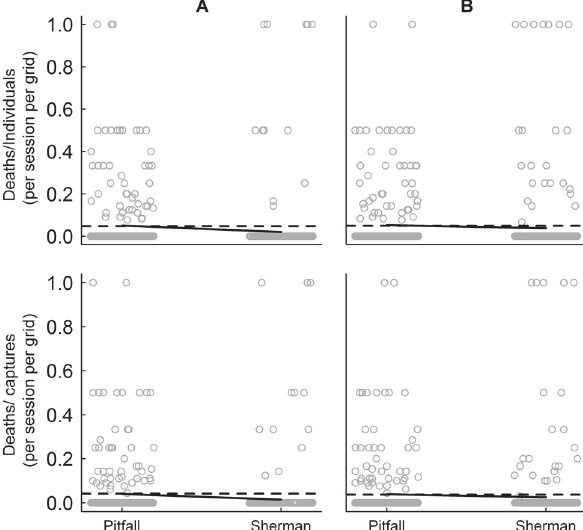
Figure 4. Number of species, individuals and recaptures in pitfall and Sherman traps. Overlapping dots are horizontally scattered to improve visualization. Two data-subsets were used for Sherman traps: only captures from Sherman traps placed adjacent to pitfall lines (column A) or from Sherman traps intercalated with pitfall lines (column B). Expected means for each type of trap estimated from constant models (dashed lines) and from models with trap type as a fixed factor (solid lines).